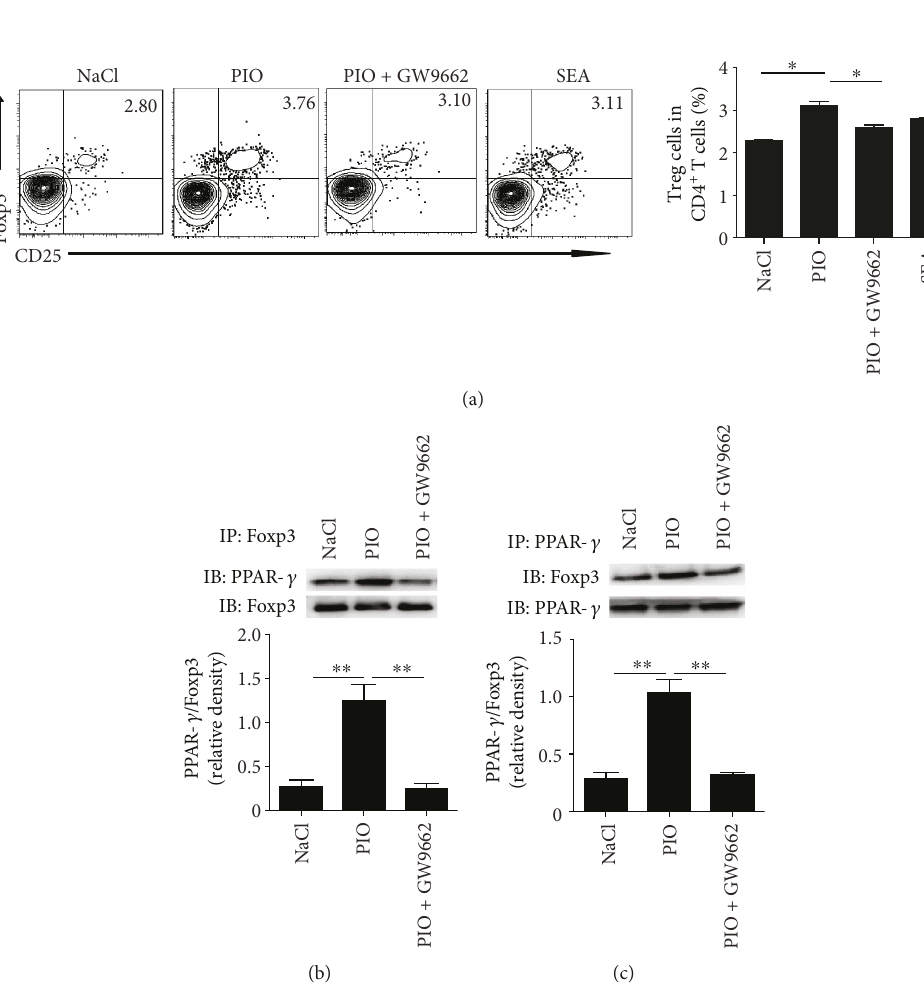
Figure 5: PPAR- γ /Foxp3 interaction promotes Treg di ff erentiation. (a) CD4 + T cells (1 × 10 6 ) were treated with pioglitazone (10 μ g/ml), SEA (25 μ g/ml), or (and) GW9662 (2 ng/ml) for 24 h, and then Treg (CD4 + CD25 + Foxp3 + ) cells were analyzed by FACS. (b) Normal puri fi ed CD4 + T cells of WT mice were stimulated with pioglitazone or GW9662 for 24h, and then CD4 + T cell fractions were subjected to immunoprecipitation (IP) with an anti-PPAR- γ antibody, and the immunoprecipitates were analyzed by immunoblotting (IB) with anti- Foxp3 or anti-PPAR- γ antibody. (c) The association of PPAR- γ and Foxp3 was con fi rmed by a reciprocal immunoprecipitation assay using anti-Foxp3. All experiments were repeated three times with similar results (ANOVA/LSD), ∗ P < 0 05 and ∗∗ P < 0 01